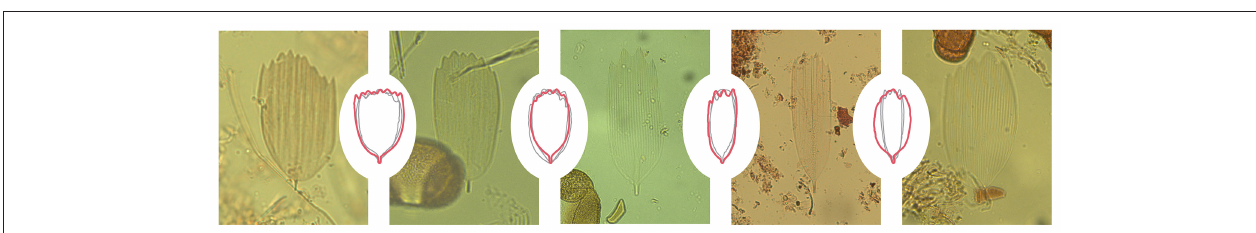
FIGURE 3 | Examples of well-preserved scales extracted from a lake sediment core showing the correspondence with spruce budworm (SBW) morphotypes generated from the shape measurements of thousands of SBW specimen